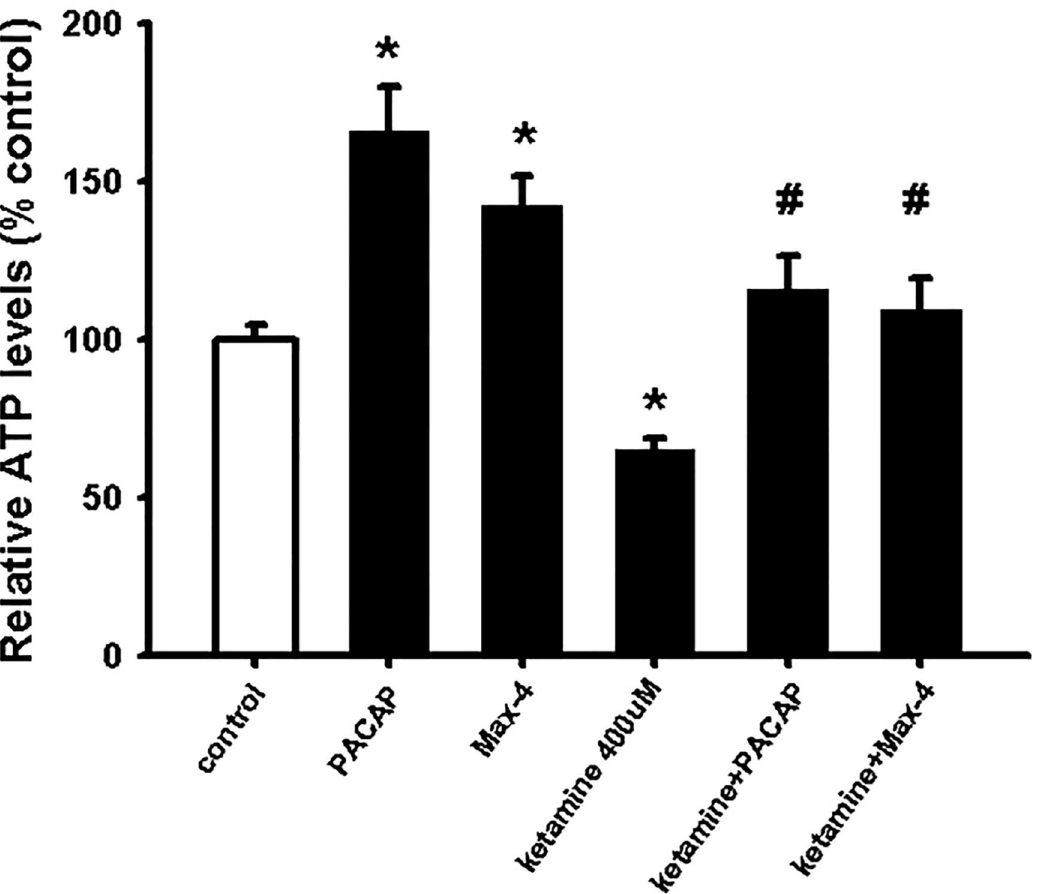
Fig 3. Ketamine-induced cell death is counteracted by PACAP via PAC-1 receptor activation. NSCs were plated as singlecells. Cells were incubatedwith 400 μ M ketamineand PACAP (100 nM) or agonistfor PAC-1; Max-4 (30 nM). After 24 hour incubation, intracellularATP levels were measuredfor cell viability. Data are shown as mean ± SEM (n = 13–39). Kruskal-Wallis followedby Dunn’stest was used. Differenceswere consideredsignificantat P < 0.05. * denotesP < 0.05 comparedwith control, # denotesP < 0.05comparedto 400 μ M